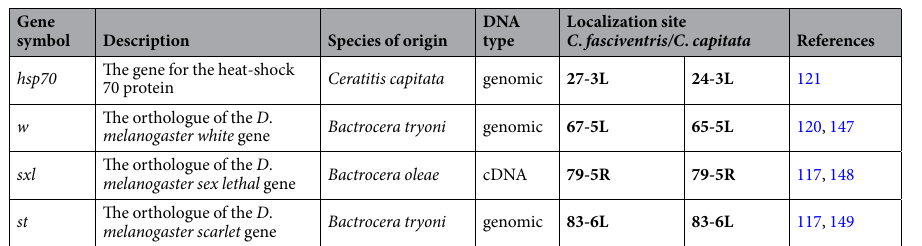
Table 1. The hybridization probes and their localization sites on the polytene chromosomes of Ceratitis fasciventris and Ceratitis capitata